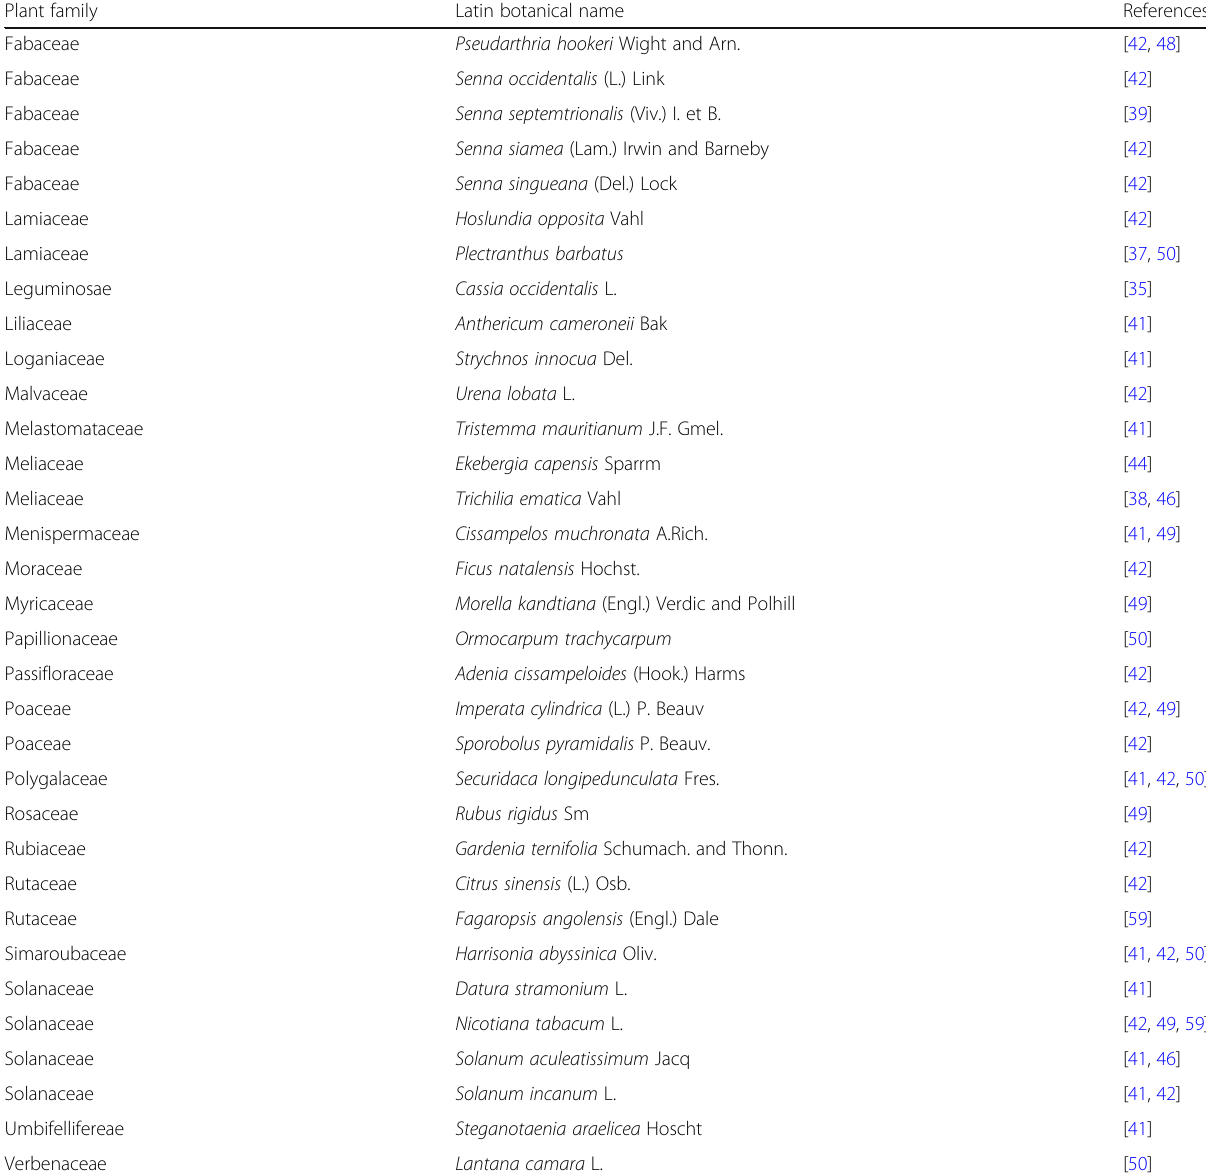
Table 1 Antivenin plants used in rural communities of Uganda (Continued) Plant